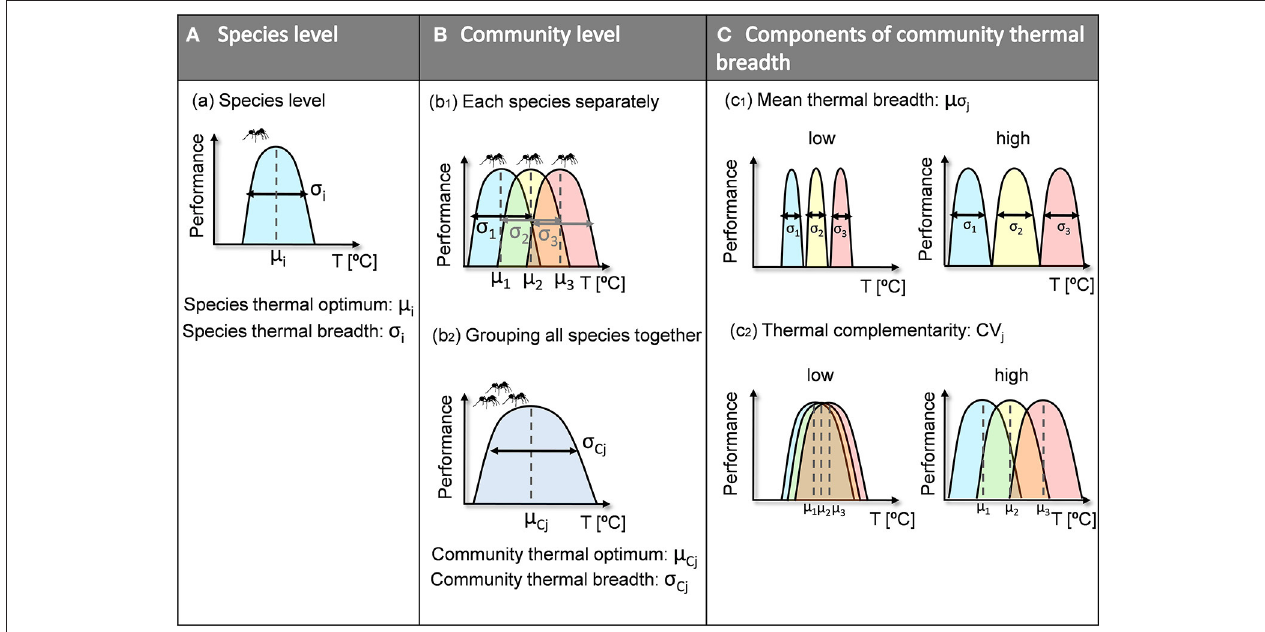
FIGURE 1 | Conceptual framework of species- and community-level thermal niches. The thermal niche of a given species (A) is characterized by the species’ thermal optimum (